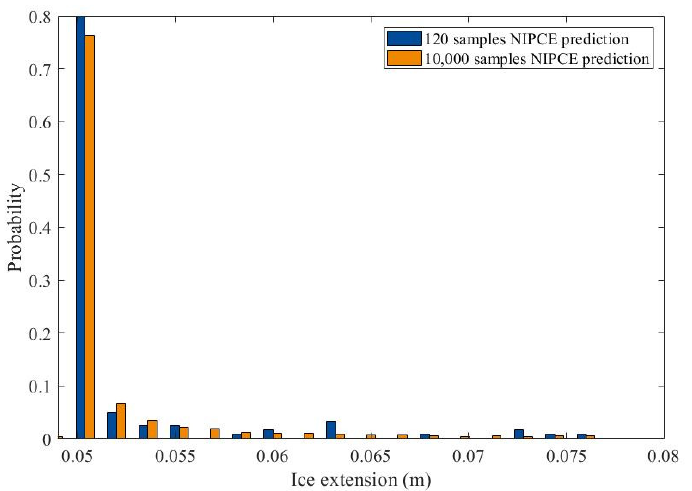
Figure 9. Comparison between NIPCE predictions for a varying sample size for the ice extension (metamodel M 3 ) and the 2PP model.